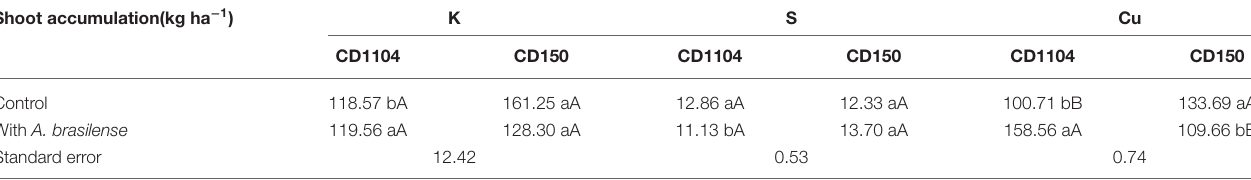
TABLE 2 | Interaction between wheat cultivars and inoculation with Azospirillum brasilense for K, S, and Cu shoot accumulation. Shoot accumulation(kg ha − 1